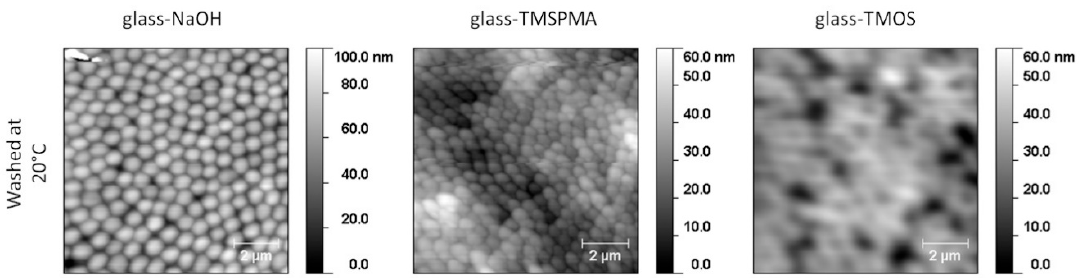
Figure 5. AFM images of PNIPAm a films spin-coated on glass-OH, glass-TMSPMA and glass-TMOS at 5000 rpm from a dispersion of 3 wt%, after being washed in water at 20 °C and 50 °C.